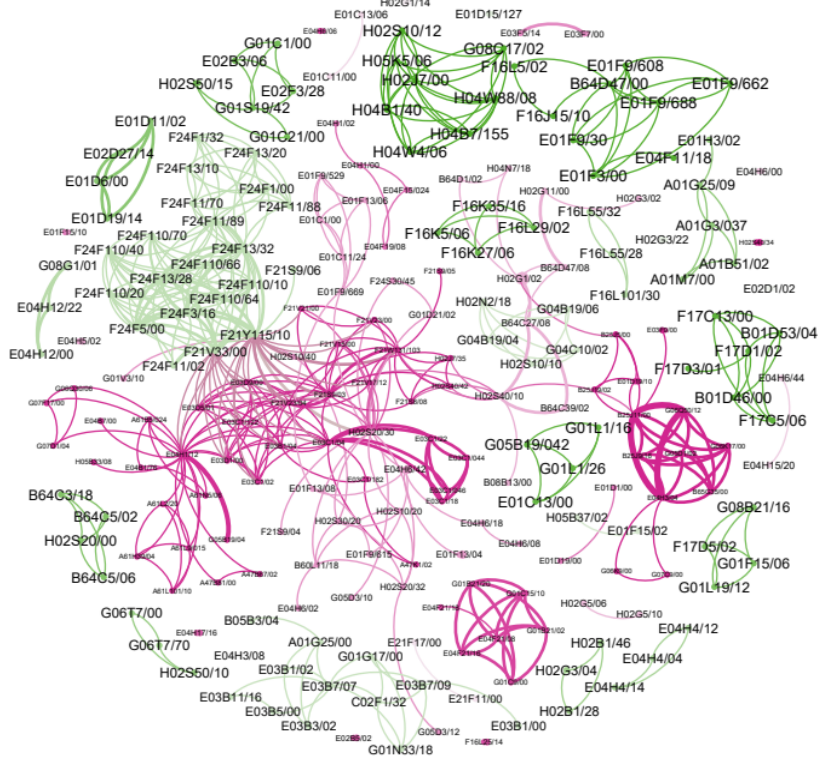
Figure 7. Digital construction innovation network (2017).